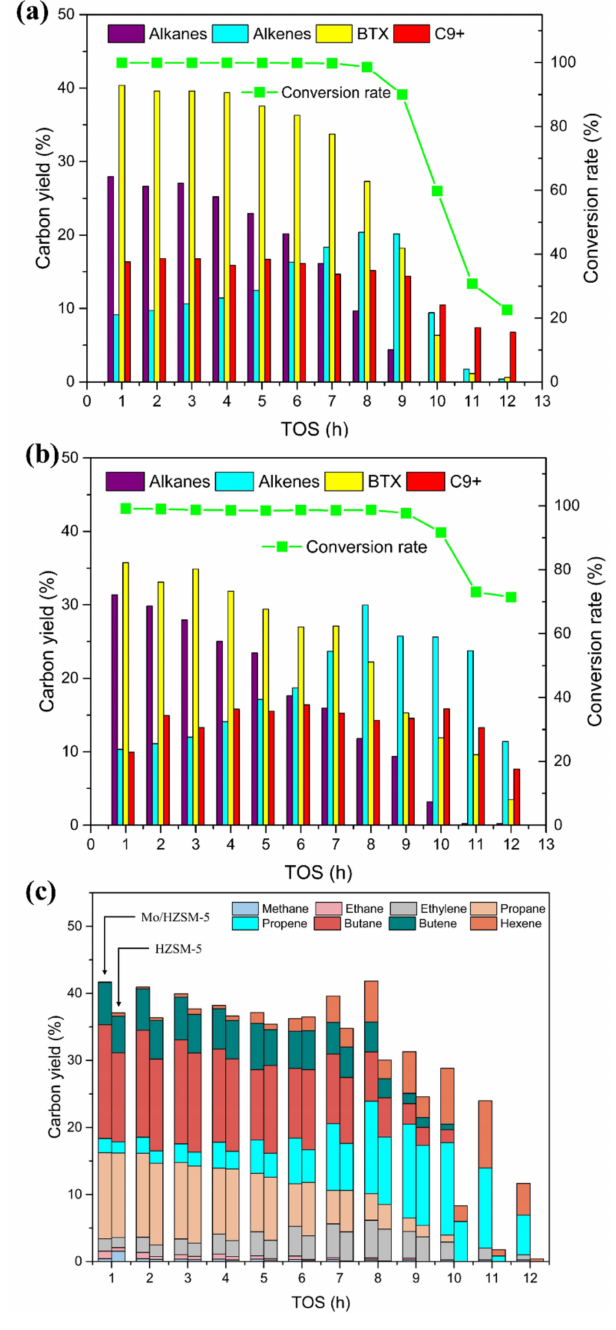
Figure 3. The results of HDO of acetone at atmospheric hydrogen pressure ( a ) conversion rate and major product groups distribution of HZSM-5, ( b ) conversion rate and major product groups distribution of Mo/HZSM-5, ( c ) detailed aliphatic product distribution, catalytic temperature: 400 ◦